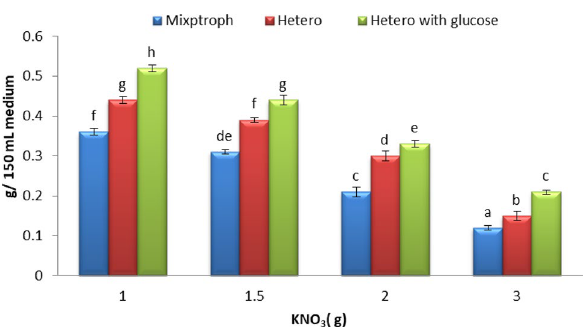
Figure 7. Effect of nitrogen concentrations in dry weight of alga ( S. obliquus ) was grown with the of Disperse orange dye (20 ppm) under different growth conditions. Par represent standard error, different letters clear the significant